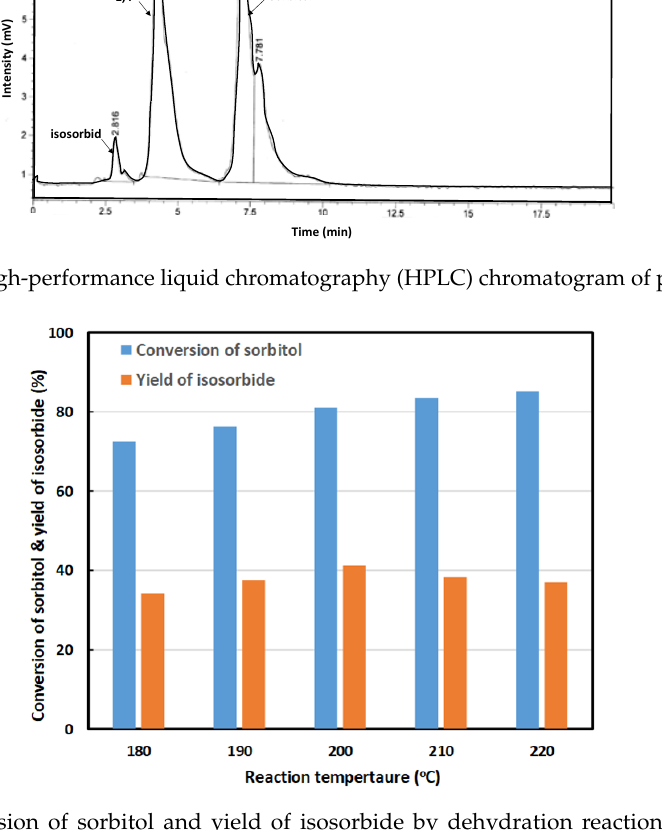
Figure 7. Conversion of sorbitol and yield of isosorbide by dehydration reaction over the BEA zeolite catalyst.